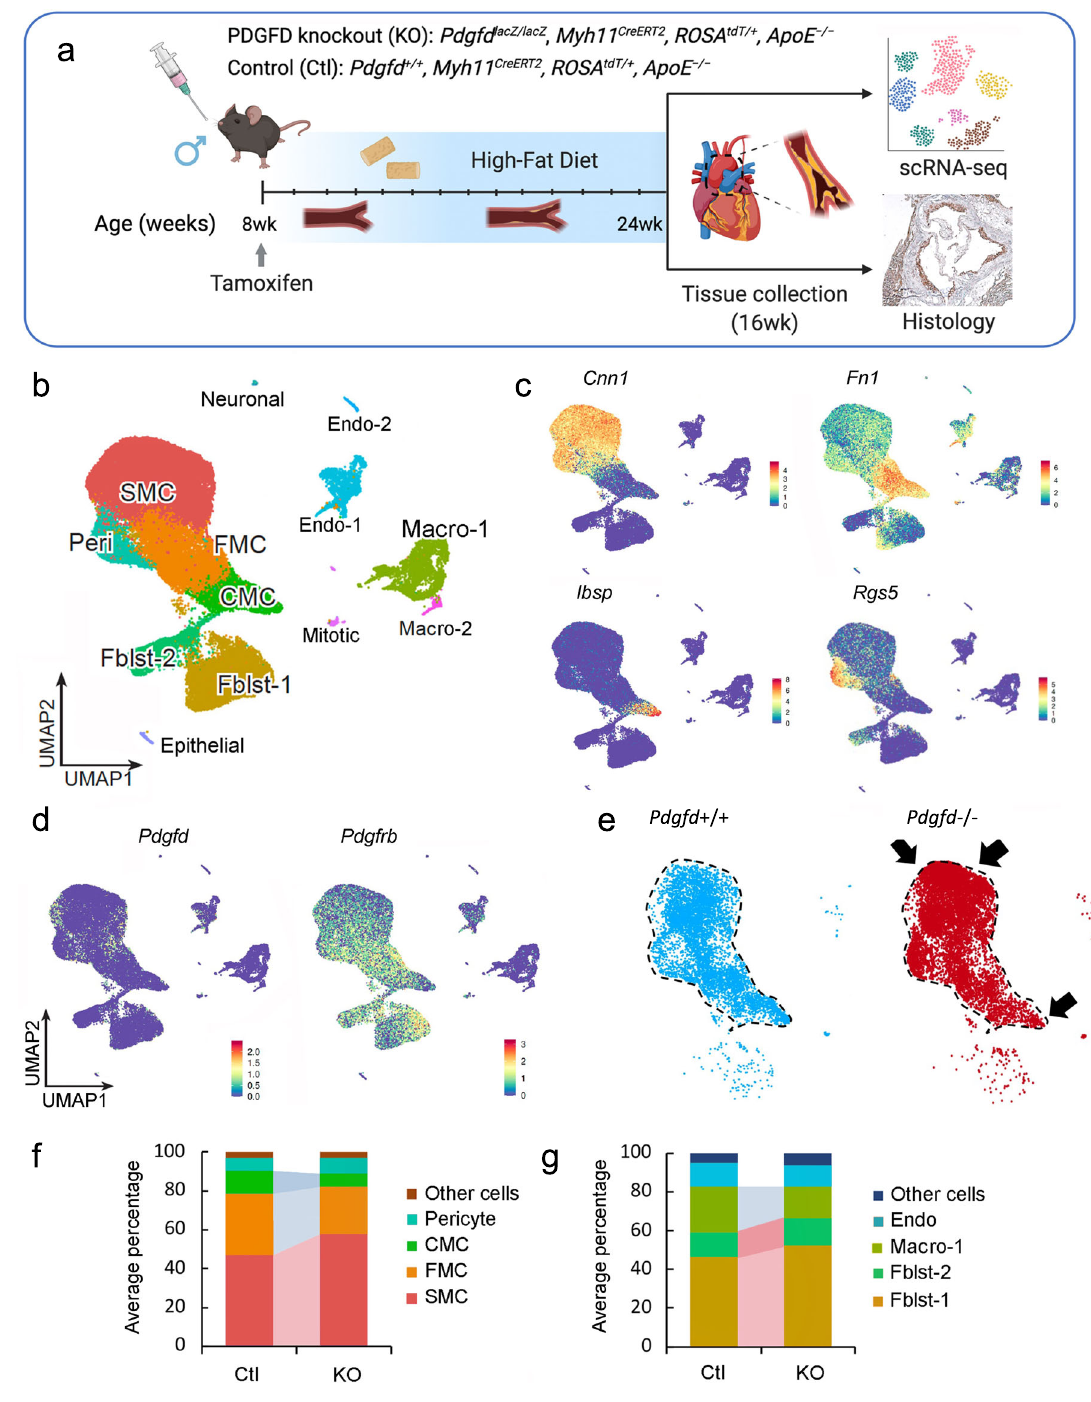
Fig.3|Single-celltranscriptomicpro fi lingofmouseatheroscleroticaorticroot in Pdgfd KO mice. a Schematic of experimental design showing that dissected aortic tissues were harvested for single cell RNA sequencing (scRNAseq) and his- tology analyses from SMC-speci fi c lineage tracing control (Ctl) and lineage tracing Pdgfd knockout(KO)mice.Eight-week-oldmice,2Ctland3KOcaptures(twomice percapture),weretreatedwithtamoxifentwiceat3-dayintervalsandsubsequently fed high fat diet for 16 weeks and then sacri fi ced. Tissues were digested to single cells,tdTomatopositive(tdT+) fl uorescenceandnegative(tdT-)cellscollectedand captured on the10x Chromium controller, libraries generated and sequenced. Created with BioRender.com. b Uniform manifold approximation and projection